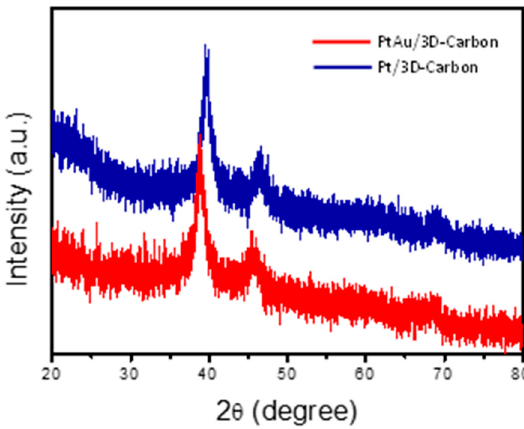
Figure 2. XRD patterns of PtAu/3D carbon and Pt/3D carbon.